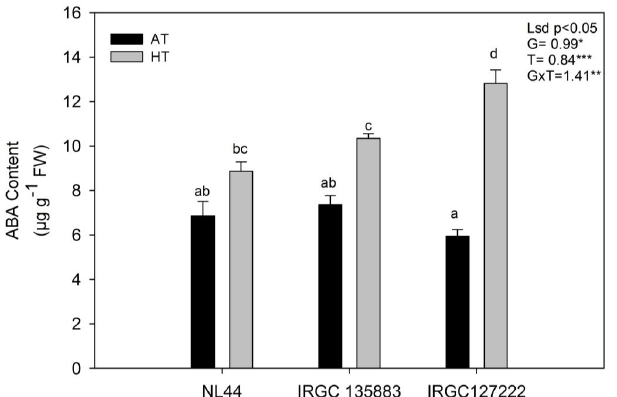
Figure 6. The effect of ambient-temperature (AT) and high-temperature (HT) exposure on abscisic acid (ABA) content of contrasting rice accessions at the reproductive stage. Means of three replicates are indicated by the vertical columns in the figure. Error bars indicate the ± SEM. The least significant difference test was used to determine significance. Means with the different letters are significantly different at level: * p < 0.05,** p < 0.01, *** p < 0.001.